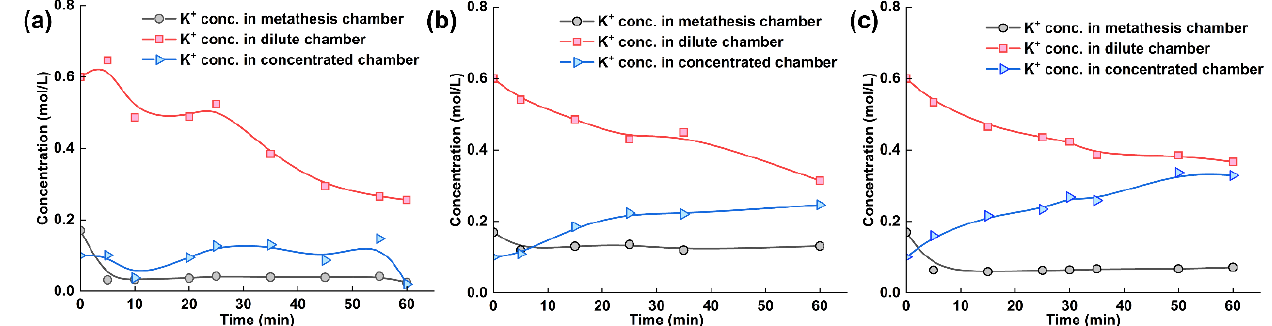
with A3 membrane and tobacco liquor; ( c ) Experimental results with TW-A membrane and tobacco